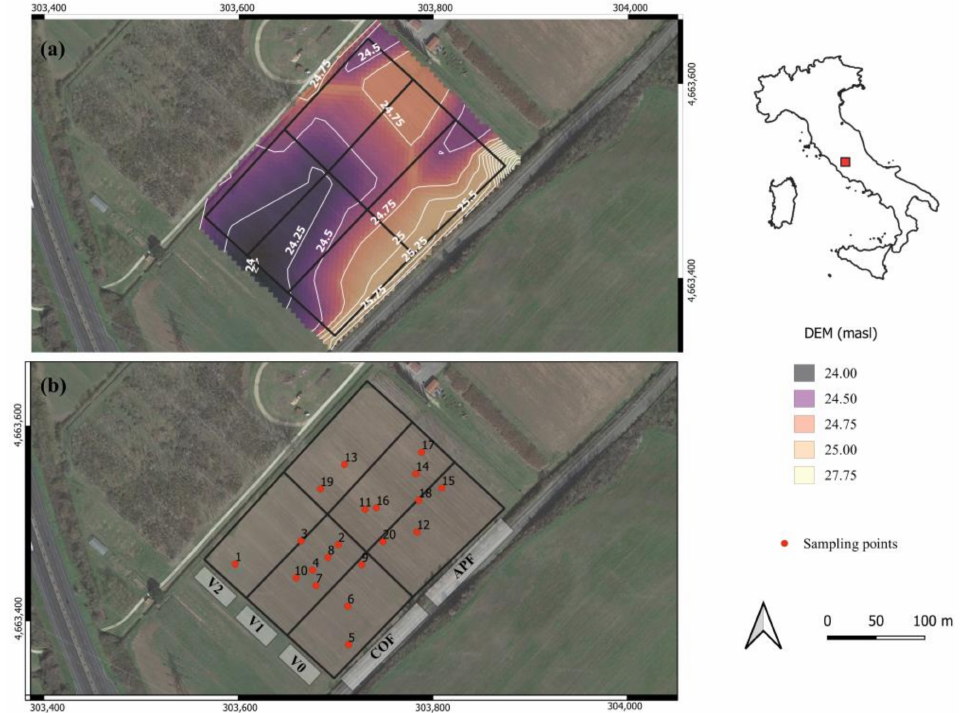
Figure 1. Digital elevation model (DEM) and contour lines of the experimental area ( a ). Experimental design indicating flood vulnerability factors (V0, V1, and V2), agronomic management (COF and APF), and the randomly selected soil sampling points ( b ). SRS: WGS84/UTM zone 33N; EPSG:32633. Number and red points correspond to the sampling